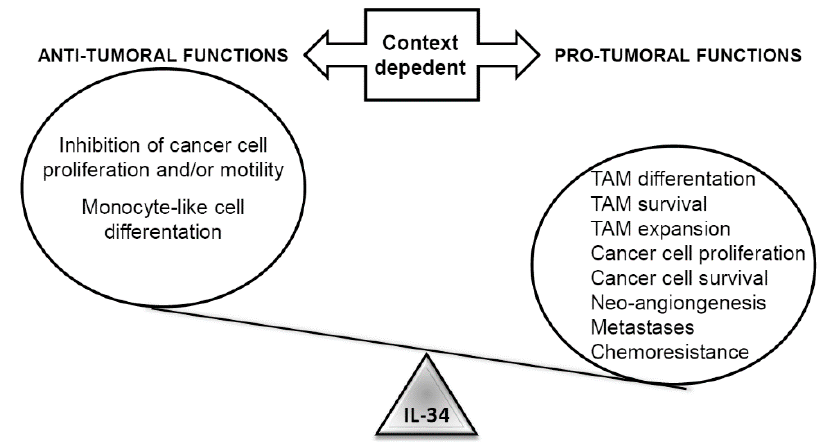
Figure 3. Schematic overview depicting the pro- and anti-tumorigenic functions of IL-34. IL-34 can exert both tumor and antitumor functions, depending on the tissue context. In some tumors, IL-34 inhibits cancer cell proliferation and/or motility, as well as monocyte-like cell differentiation. Conversely, in the majority of cases, IL-34 plays a tumor-promoting role by acting directly on transformed cells, to increase their proliferation/survival, indirectly favoring tumor-associated macrophage (TAM) differentiation, survival, and expansion.